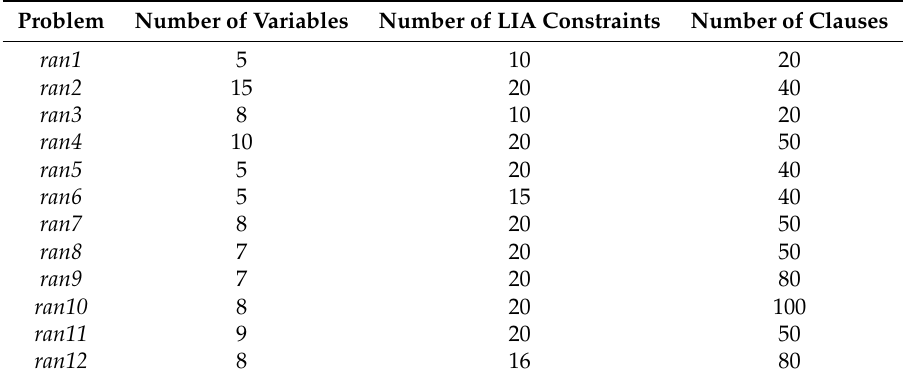
Table 1. Properties of test problems with random structure.